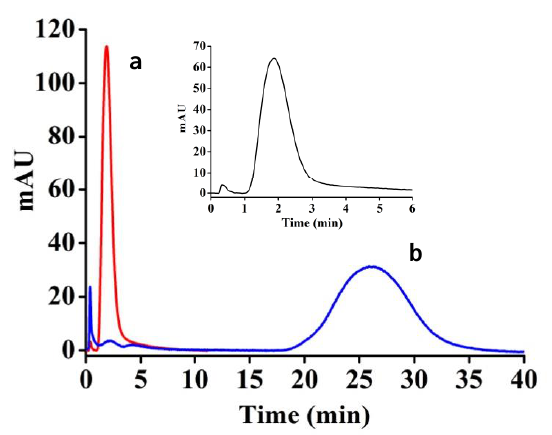
Figure 8. Chromatograms of serum proteins on ( a ) NIP; and ( b ) MIP (F in Table 1). Columns: 4.6 mm × 20 mm. Sample: 1/4 diluted bovine serum. Injection volume: 20 μ L. Mobile phase: 100 mmol/L PBS (pH 7.20) at 0.1 mL/min. Detection wavelength 278 nm.